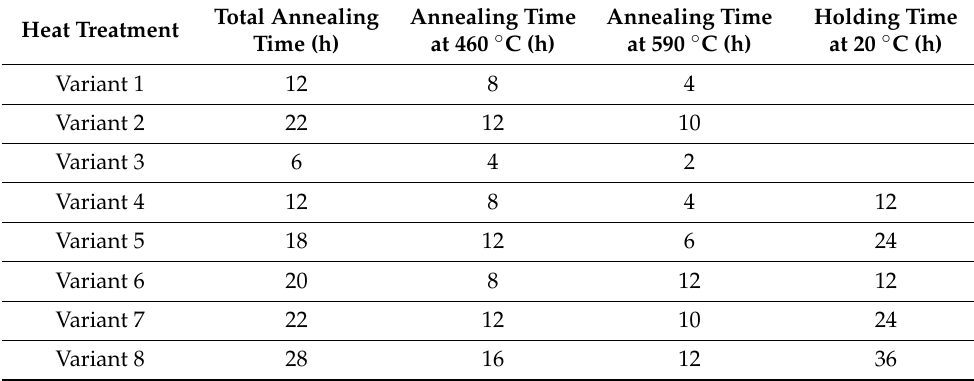
Table 4. Annealing times for samples at particular